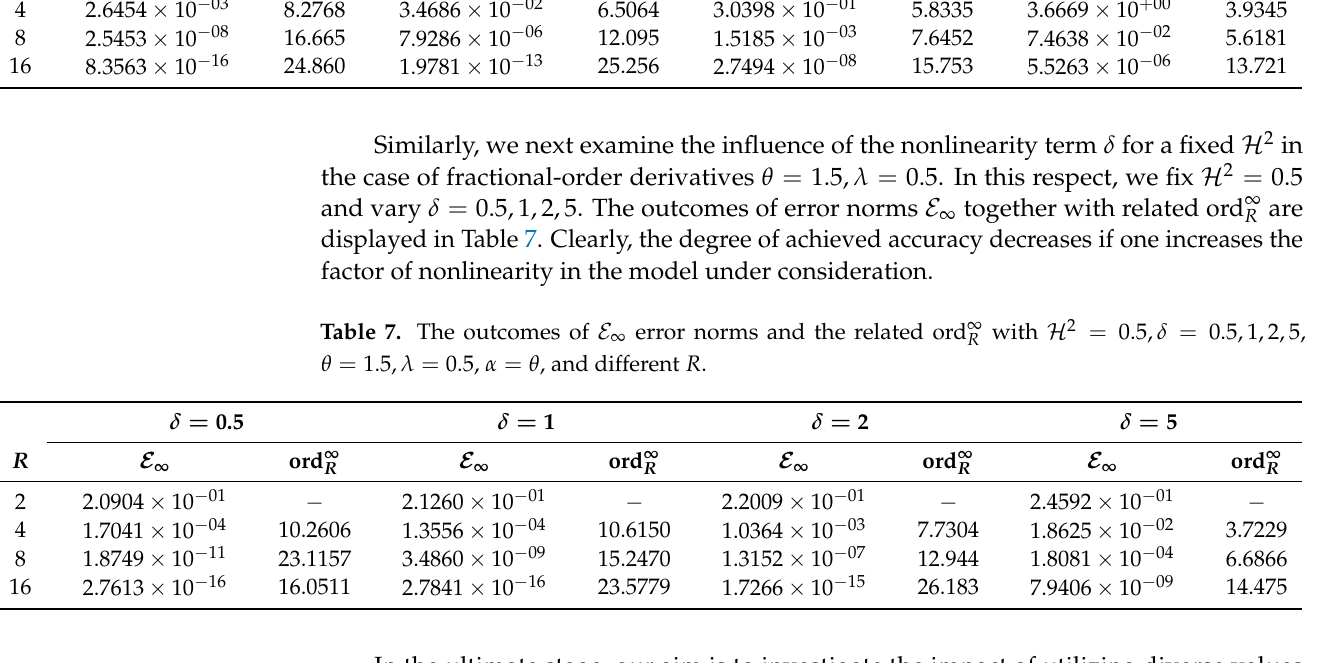
∞ error norms and the related ord E